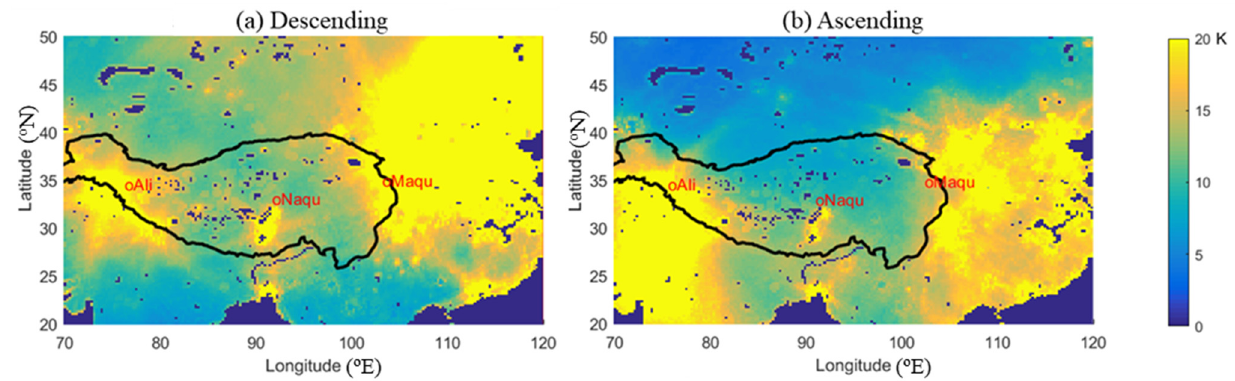
Figure 2. RMSE computed between the SMOS 𝑇 (cid:3003)(cid:3043) observations and simulations produced by the CMEM model for both ( a ) ascending and ( b ) descending overpasses.